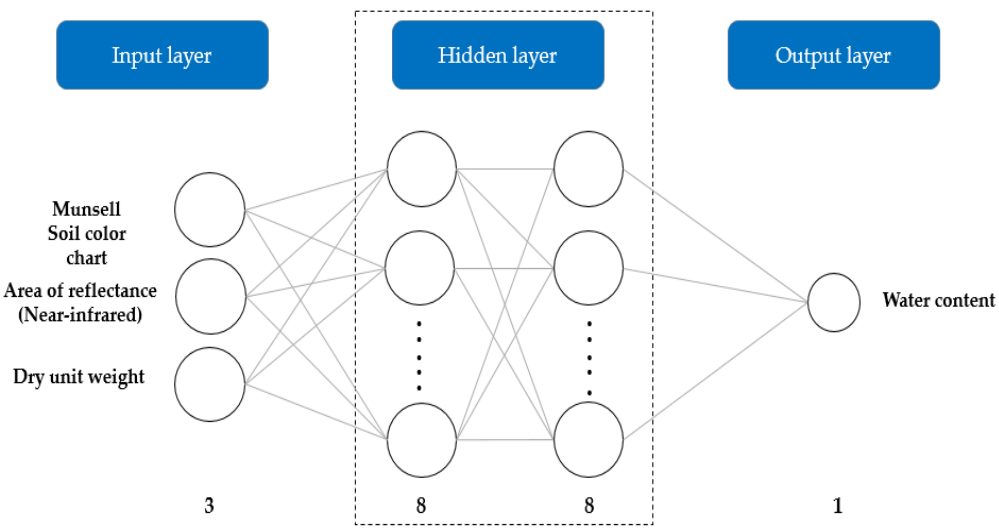
Figure 8. Structure of the artificial neural network (ANN) model for the estimation of soil water content.